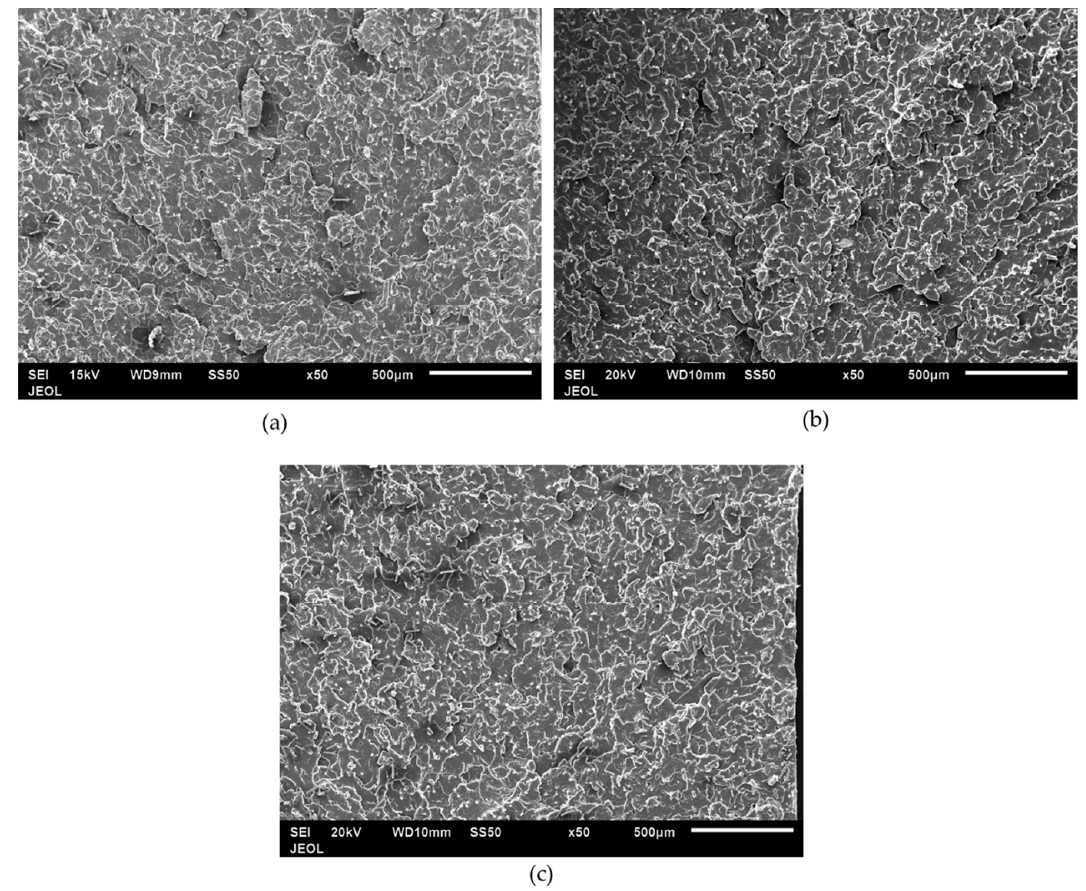
Figure 16. SEMimagesofimpactfractureofhybridcompositesof( a )PP10SCF / 5GNP,( b )PP / 10SCF / 5nTiO 2 , Figure 16. SEM images of impact fracture of hybrid composites of ( a ) PP10SCF/5GNP, ( b ) and ( c ) PP / 10CF / 2.5GNP / 2.5nTiO 2 PP/10SCF/5 nTiO 2 , and ( c ) PP/10CF/2.5GNP/2.5 nTiO 2.